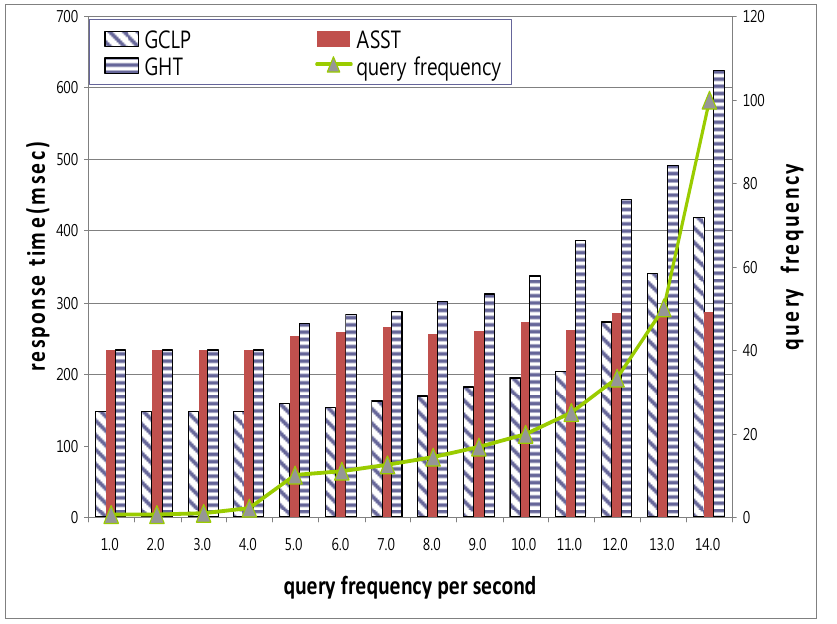
Figure 10. Response time with increased query